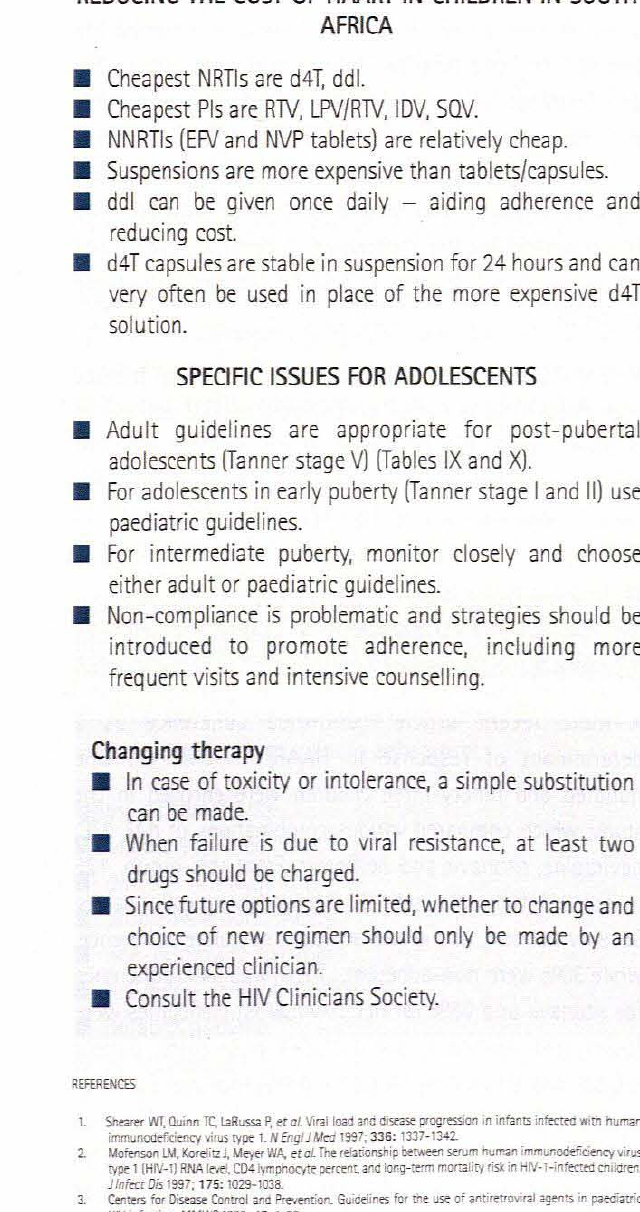
TABLE X. TANNER STAGING FOR Breasts Pre-adolescent Breast and papilla elevated as small mound; areola diameter increased Breast and areola enlarged, no contour separation Areola and papilla form 2" mound Mature: nipple projects, areola part of general breast contour